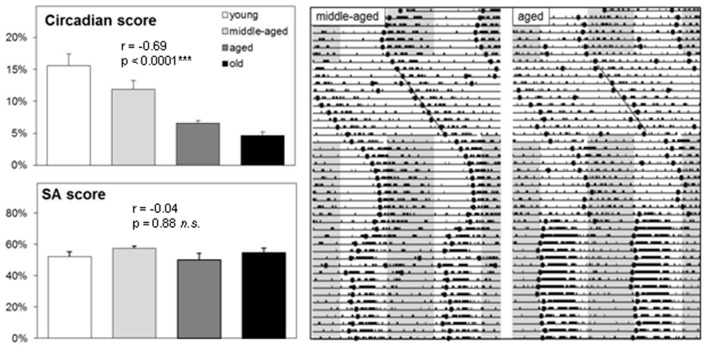
Running wheel activity and spontaneous alternation (SA) performance of CD1 mice. Left: Group averages of circadian score and SA score (see text for further details on the correlations). Error bars represent SEM. Right: Representative double-plotted actograms (46 days) of a middle-aged and aged CD1 mouse. Gray areas indicate darkness (12:12 LD). Mice were kept under a 12:12 light-dark cycle, except during a constant light (LL) period of 11 days to asses free-run patterns. The circadian score was based on the average distance of calculated daily activity onsets (black dots) during LL to a linear trend line.